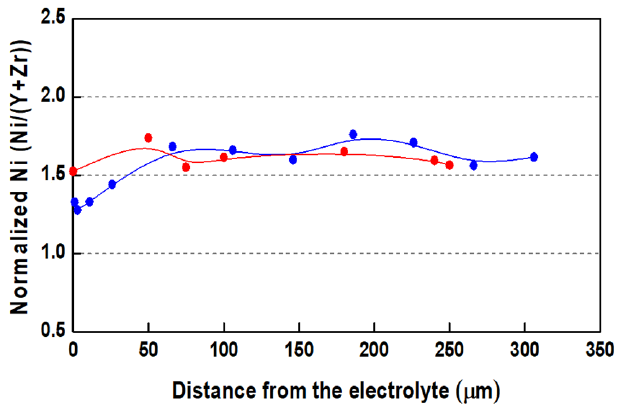
Figure 5. Normalized Ni content from edge to edge of bare anode after initial reduction ( • ) and after 15 redox cycles ( ).